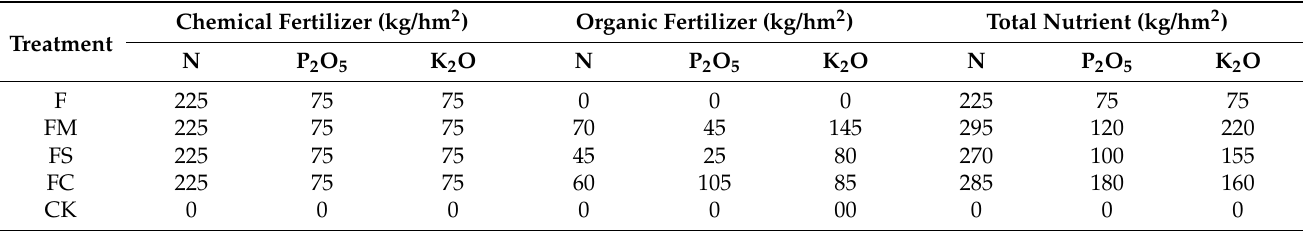
Table 2. Experimental treatments and fertilization with different organic